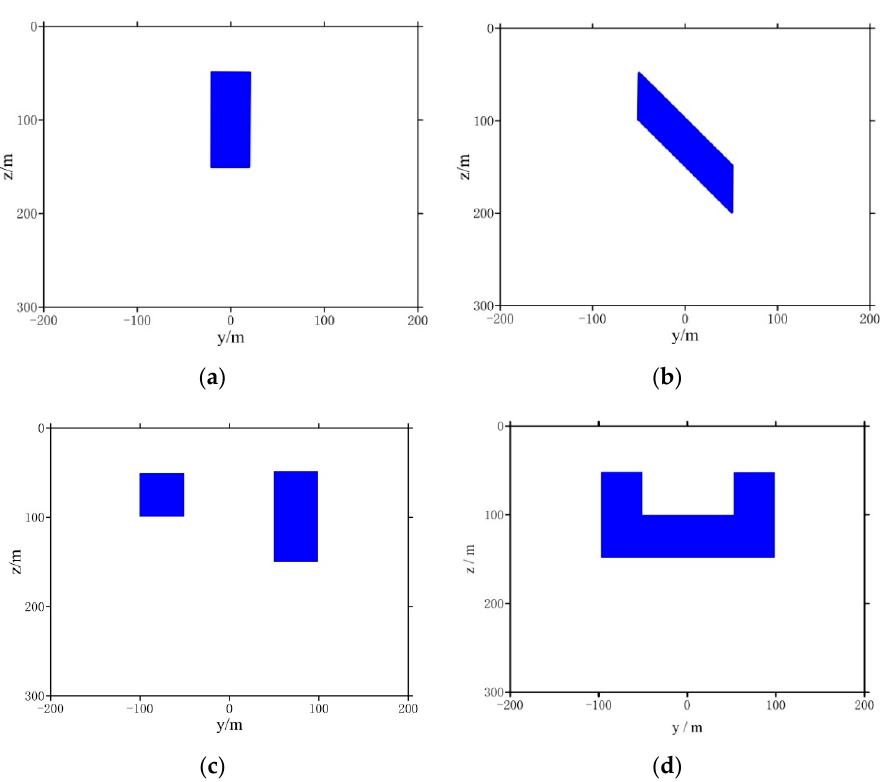
Figure 2. The cross − section through the x -axis of the 2D models with density 1 g/cm 3 . ( a ) rectangular prism, ( b ) dipping prism, ( c ) parallel prism, ( d ) U prism.